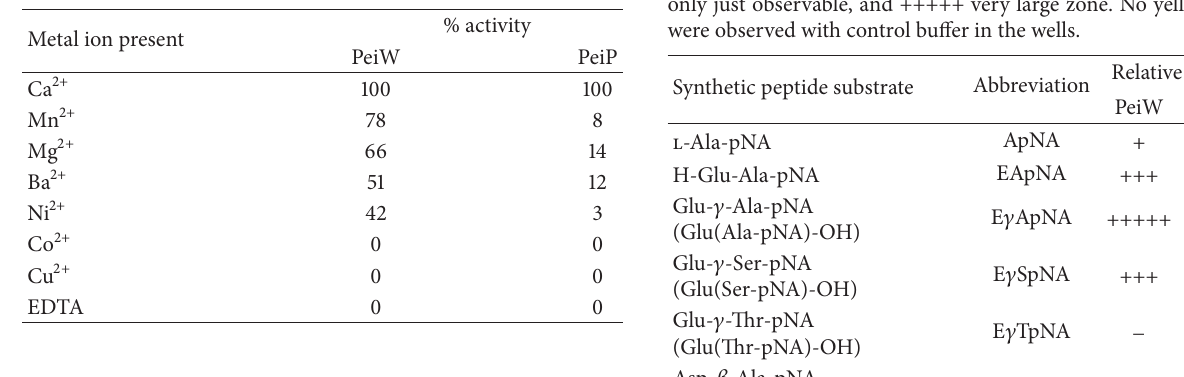
Table 1: Activation (% activity) of PeiW or PeiP by divalent metal ions in a synthetic peptide assay. 100% activity corresponded to 0.245 U mg −1 for PeiW and 0.115 Umg −1 for PeiP.